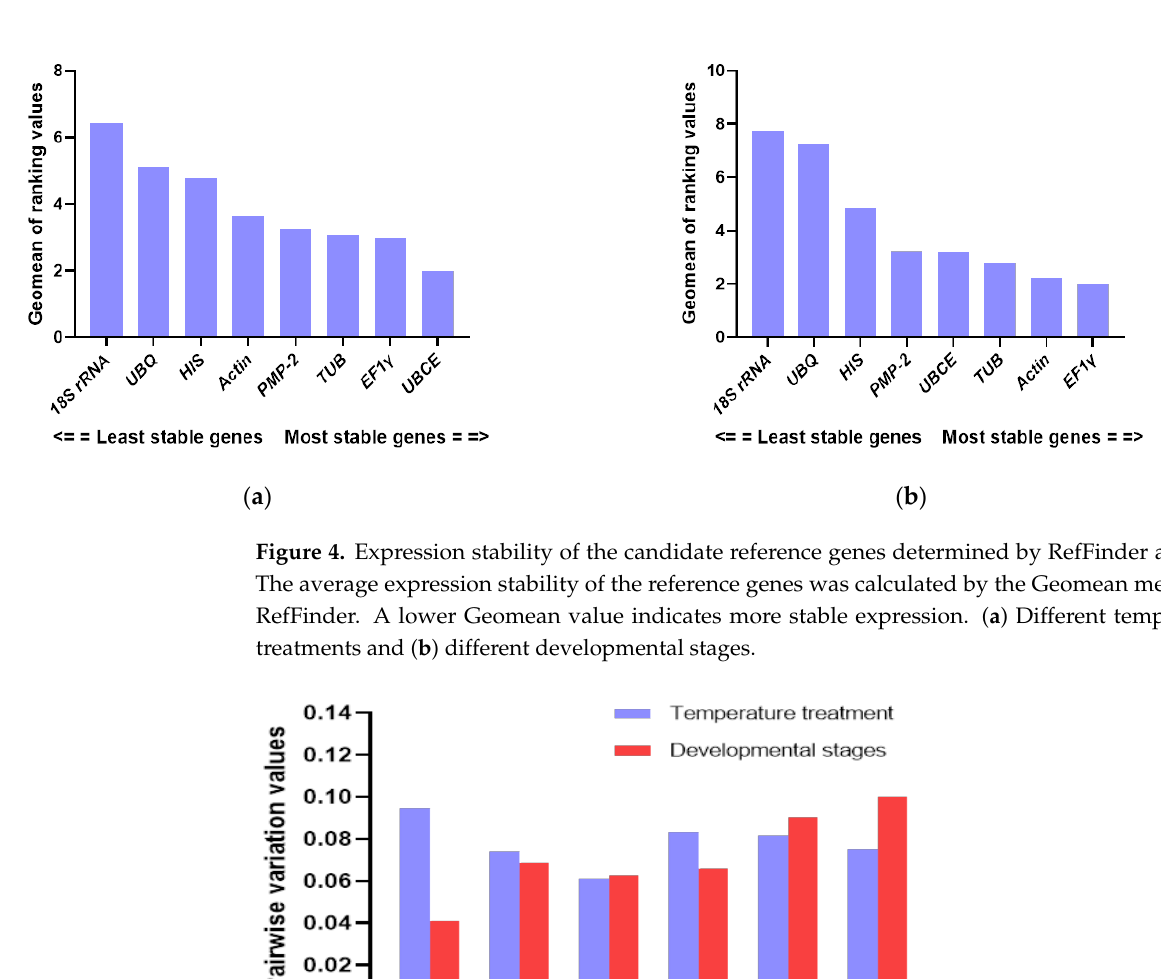
Figure 3. Average expression stability values (MV) of the candidate reference genes calculated by geNorm at ( a ) different temperature treatments and ( b ) different developmental stages.